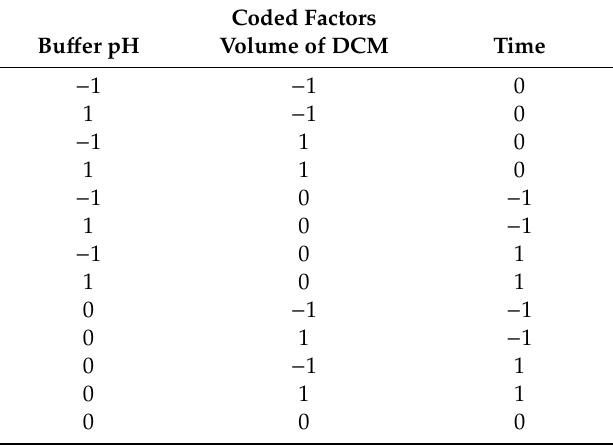
Table 3. The Box–Behnken